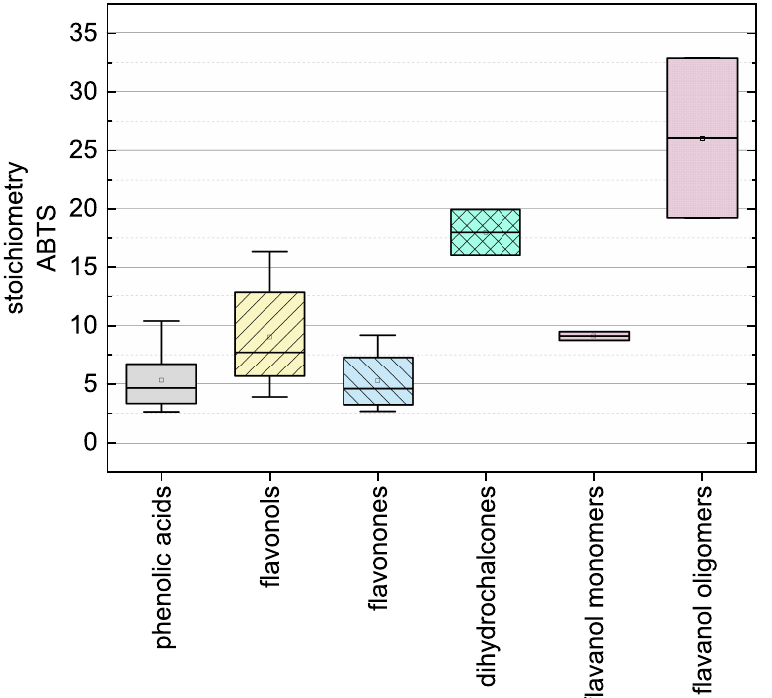
Figure 6. Boxplot of the mean stoichiometry values for subgroups of the phenolic compounds tested in the ABTS assay. Error bars represent range within 1.5 ×